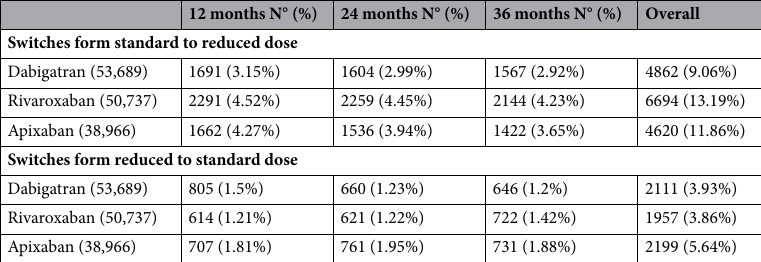
Table 4. Absolute and relative frequencies of dosage adjustments from standard to reduced dose and from reduced to standard dose at first and subsequent prescriptions.